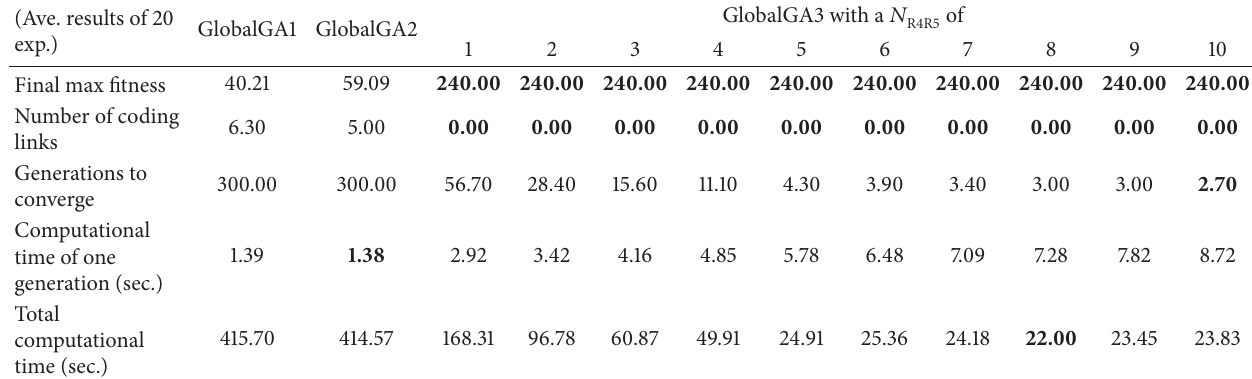
Table 4: Computational efficiencies of different GlobalGAs based on Case